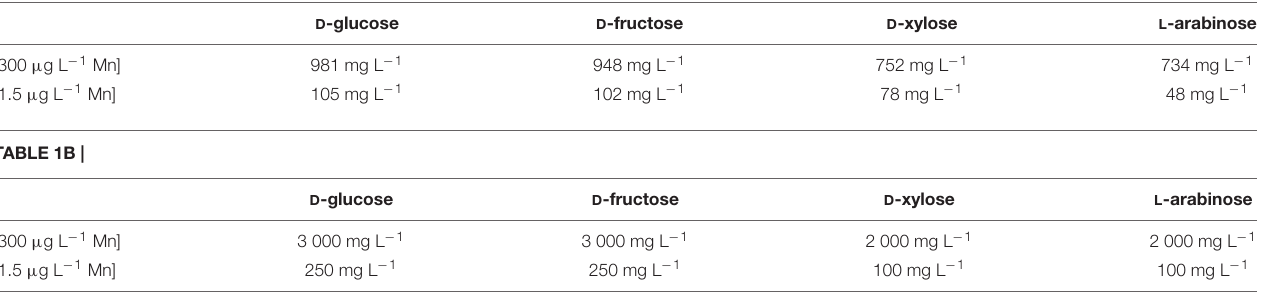
TABLE 1A | Copper(II) ion toxicity of A. terreus NRRL1960 grown on four different carbon sources in liquid minimal media either under manganese(II) ion limitation (1.5 µ g L − 1 ) or under manganese(II) ion sufficiency (300 µ g L − 1 ). D -glucose D -fructose D -xylose